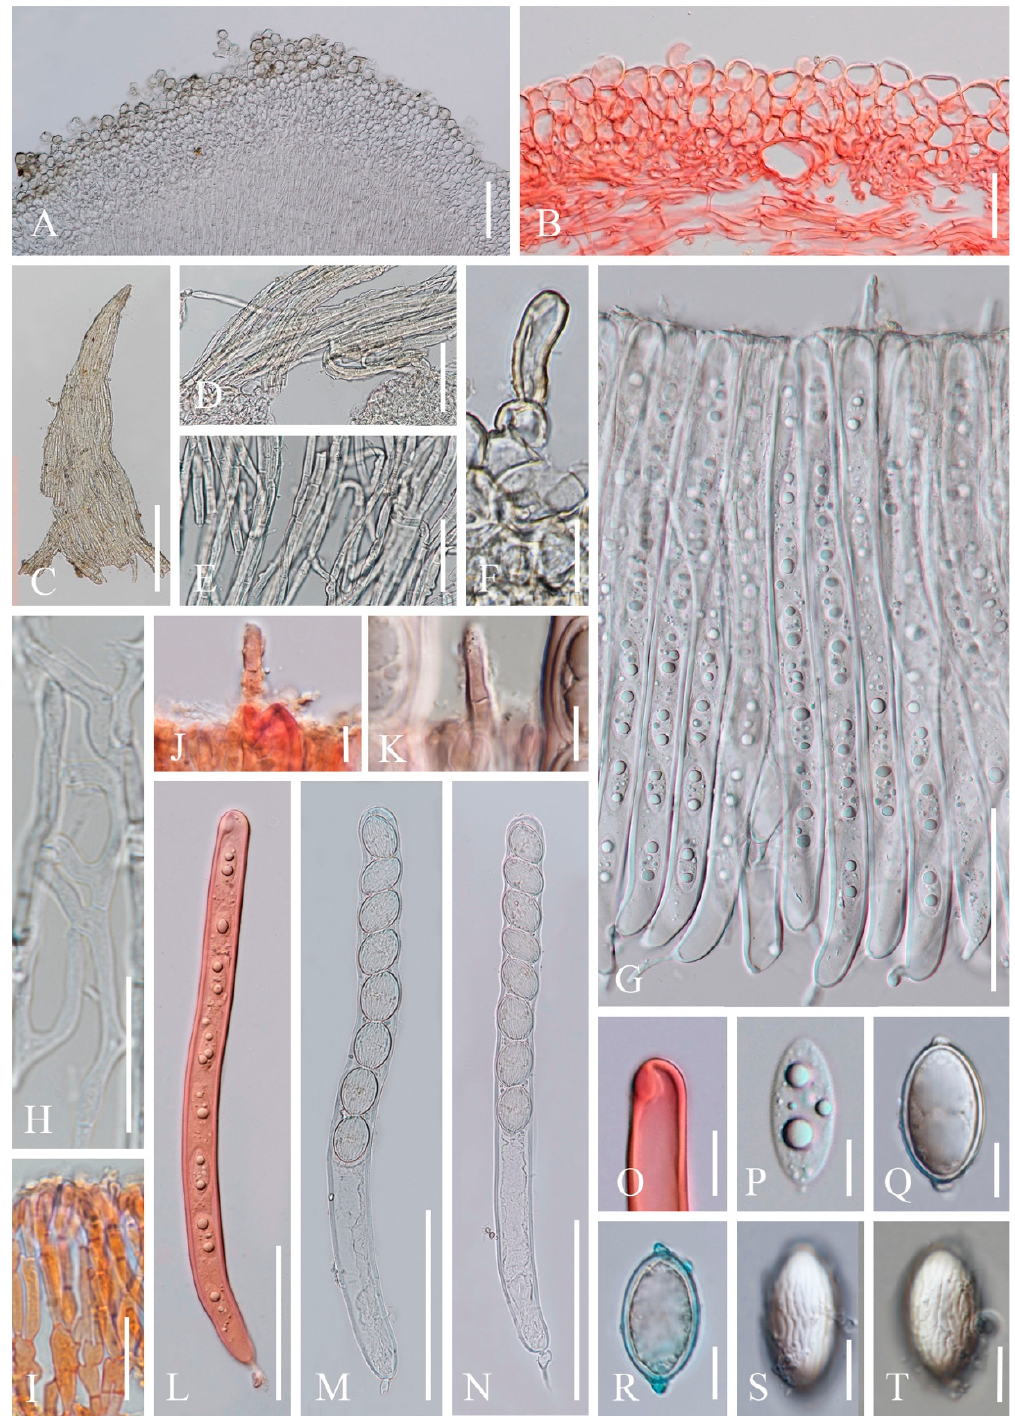
Figure 8. Cookeina speciosa (MFLU 21-0157). ( A ) Vertical section of stipe ectal excipulum. ( B ) Vertical section of receptacle ectal excipulum. ( C – E ) Triangular-shaped compound hairs. ( F ) Monilioid process. ( G ) Hymenium including setae from an immature apothecium. ( H ) Paraphyses. ( I ) Apices of paraphyses in CR. ( J , K ) Hymenial setae in CR. ( L ) Immature ascus and ascospores in CR from an immature apothecium. ( M , N ) Asci and ascospores from a mature apothecium. ( O ) Apex of ascus in CR. ( P ) Immature ascospore. ( Q – T ) Mature ascospores. [( R ) Ascospore in CB.] Scale bars ( A , D , G , N–L ) = 100 μ m; ( B , F ) = 50 μ m. ( C ) = 200 μ m; ( E , H , I , O–T ) = 20 μ m.